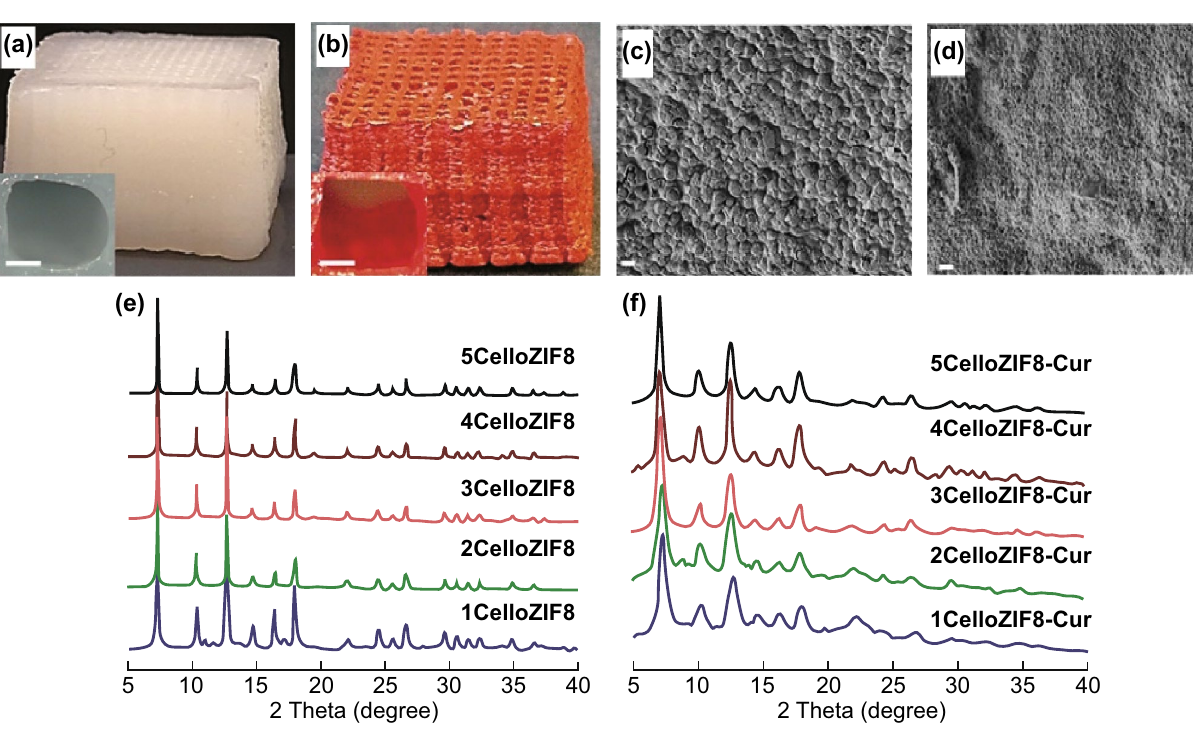
Fig. 20 3D printed scaffolds: a 4CelloZIF8 and b 4CelloZIF8-Cur. Insets are images representing the pores, with the scale bar representing 0.5 mm. SEM images of c scaffold 4CelloZIF8 and d scaffold 4CelloZIF8-Cur. Scale bar = 1 µm. e PXRD patterns of CelloZIF8 hybrids using different ZIF-8 and f different ZIF-8 loadings while keeping Hmim:Zn to 35:1 and curcumin to 30 mg, showing that the crystallinity and the framework are maintained with different curcumin and Zn loadings. Reprinted with permission from Ref. [149]. Copyright 2019 Wiley-VCH Verlag GmbH & Co. KGaA,